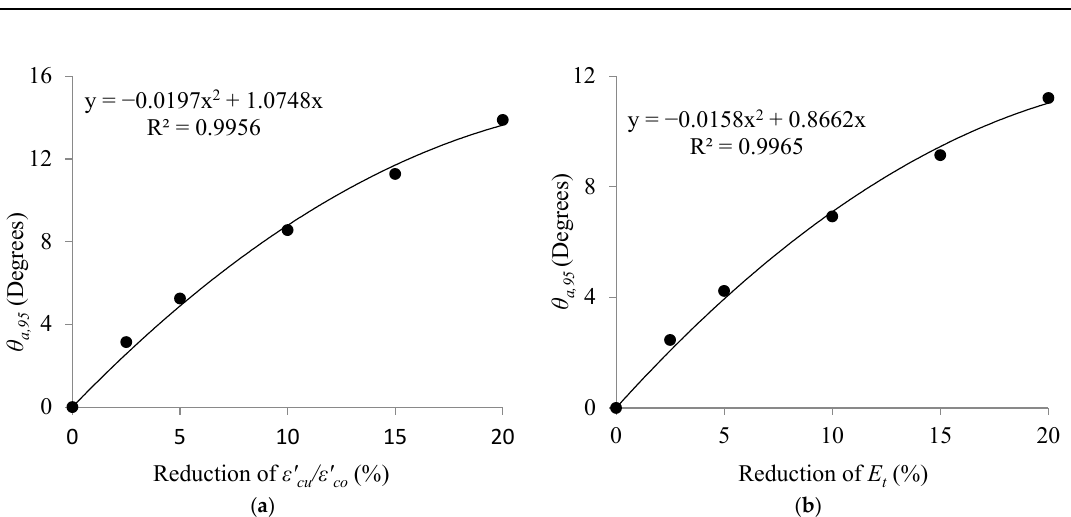
Figure 11. Variations of 𝜃 (cid:3028),(cid:2877)(cid:2873) with respect to reductions of ( a ) 𝜀 (cid:3030)(cid:3048)(cid:4593) /𝜀 (cid:3030)(cid:3042)(cid:4593) and ( b ) 𝐸 (cid:3047) .